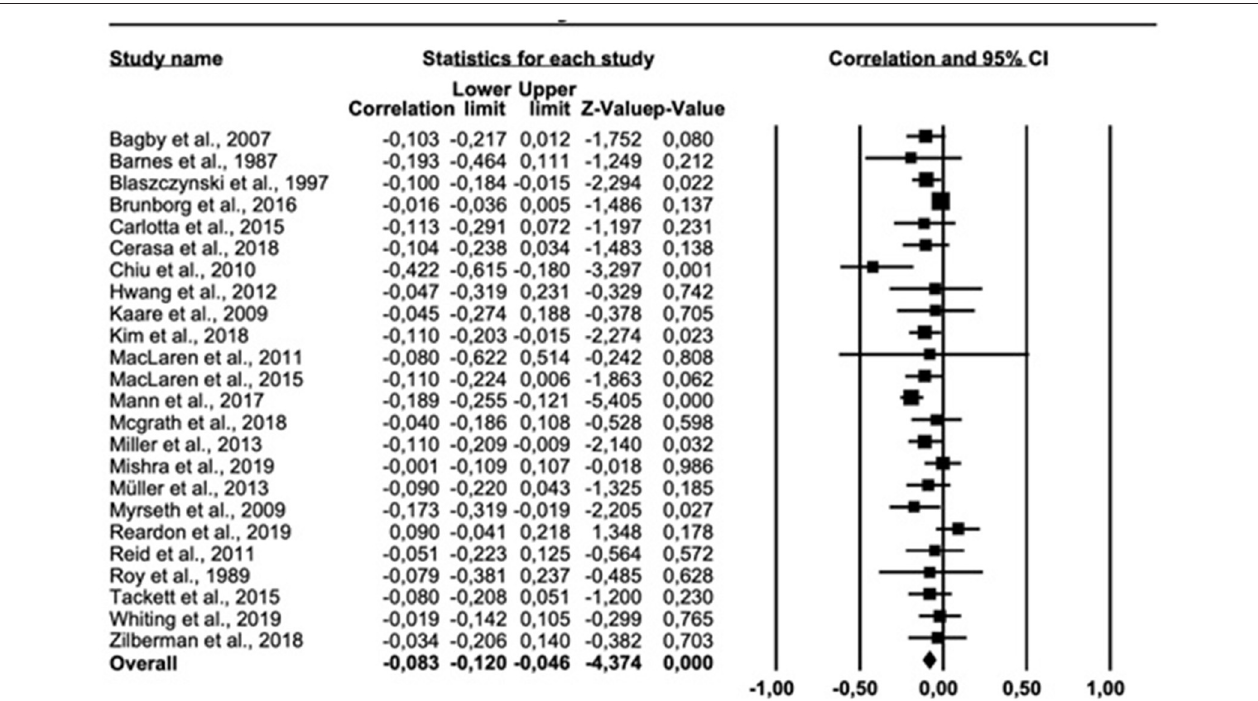
FIGURE 6 | Forest plot showing the relationship between gambling problems and extroversion.